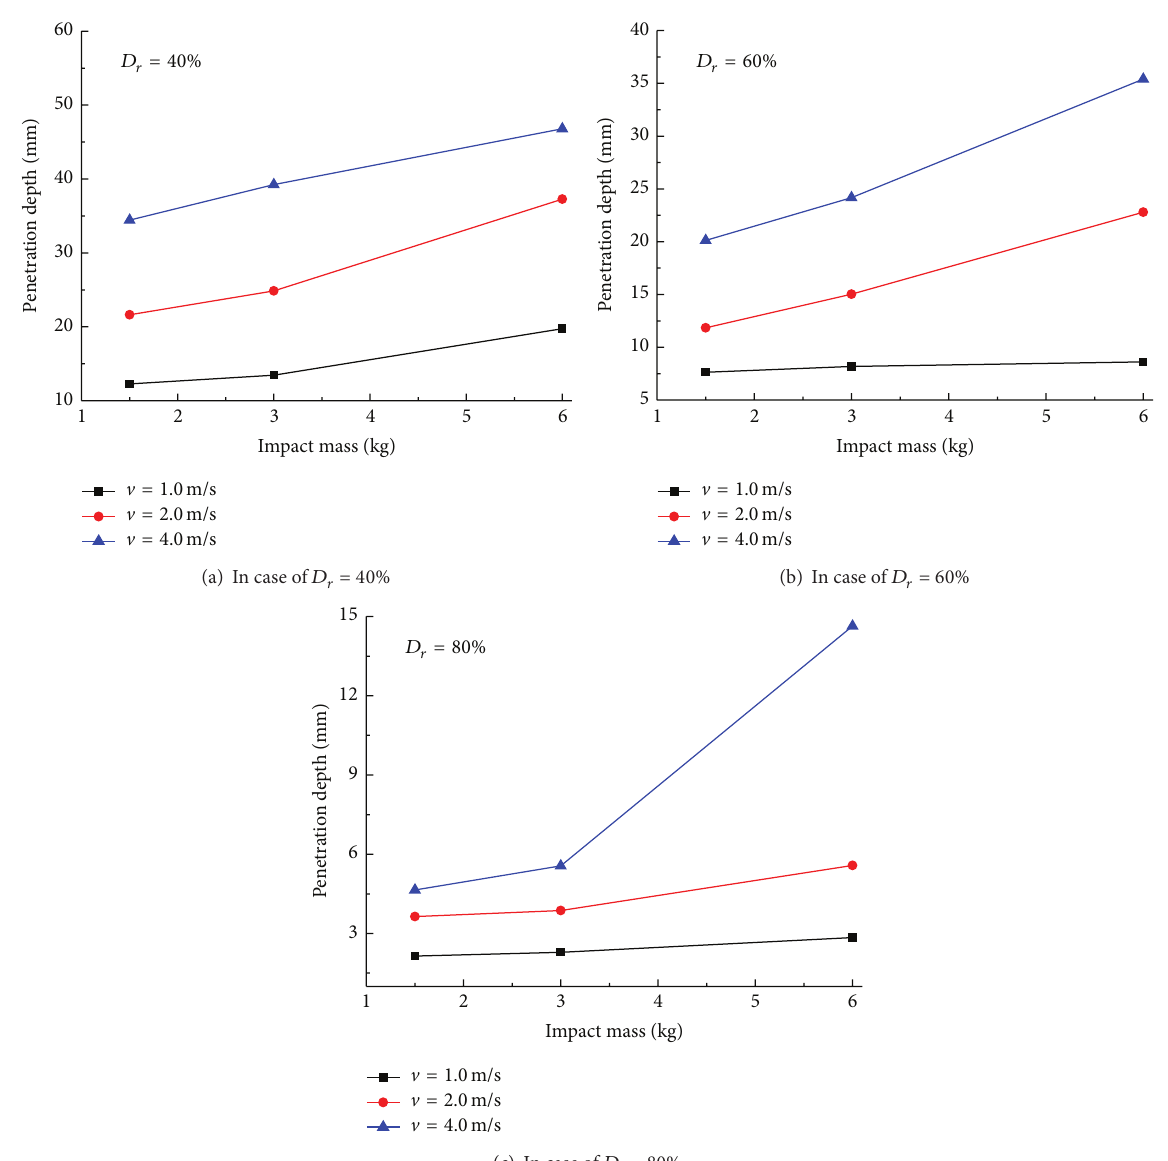
Figure 19: Effect of impact mass on penetration